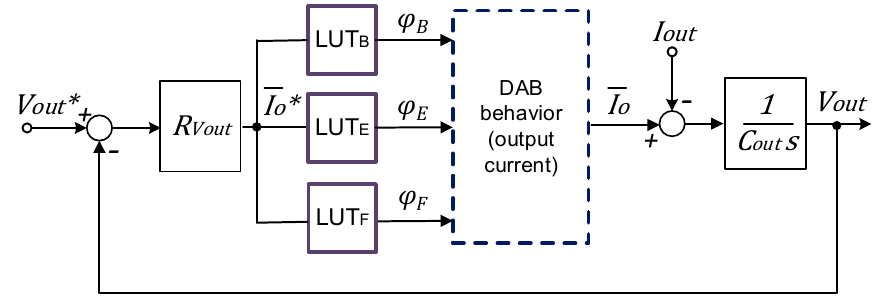
Figure 7. Control schematic for an arbitrary modulation (e.g., optimized).